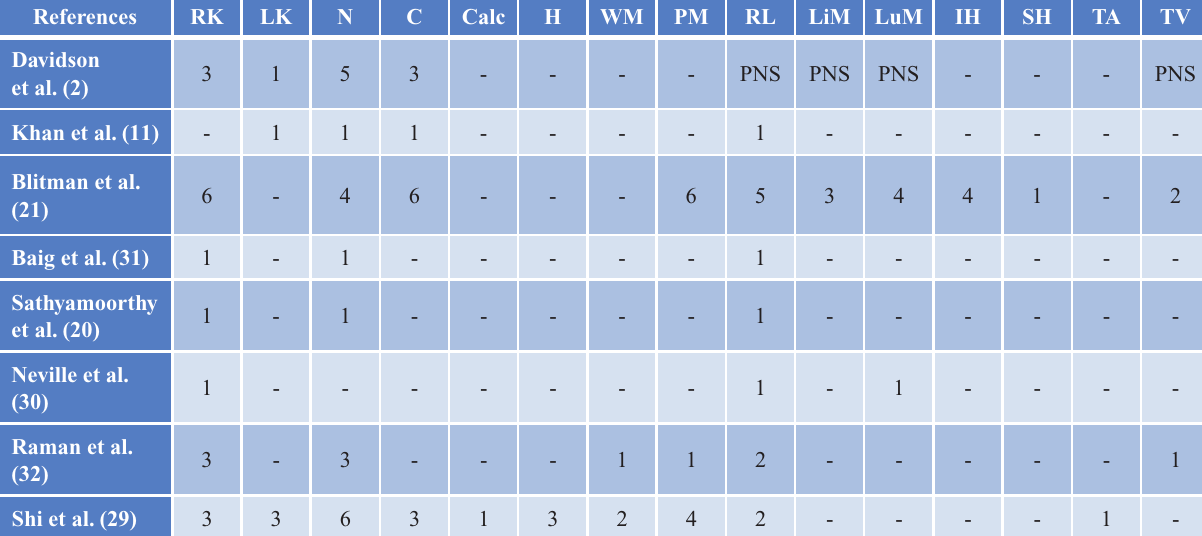
Table 1. CT features of